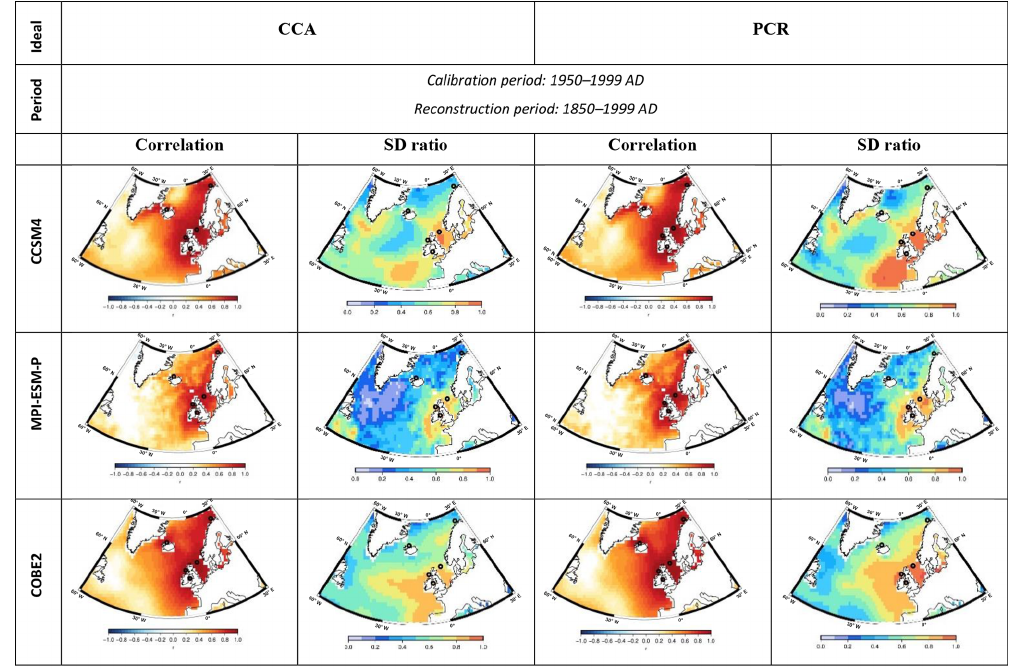
Figure 1. Correlation coefficient (first and third column) and SD ratio (second and fourth column) between the reconstructed and the original SST anomaly evolution of the NA field during the industrial era. The results regard the ideal experiment and are given for the recent calibration period (1950–1999 AD) and for the two different reconstruction methods (first and second column CCA, third and fourth column PCR) for the models CCSM4 (first row) and MPI-ESM-P r1 (second row) and the reanalysis data COBE2 (third